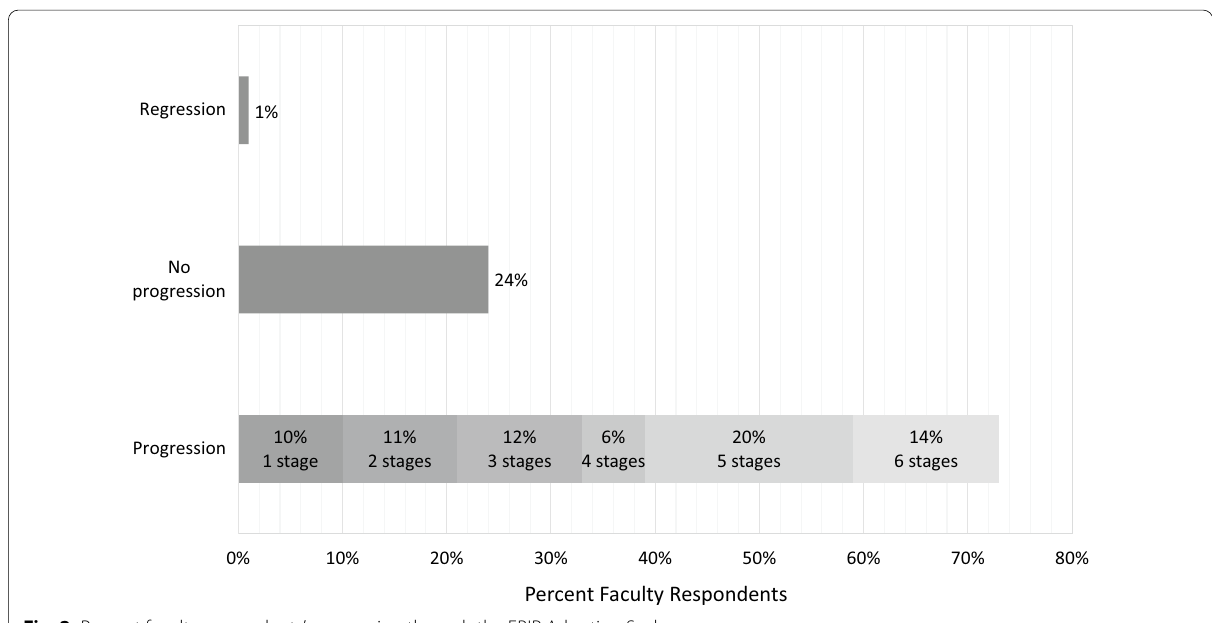
Fig. 2 Percent faculty respondents’ progression through the EBIP Adoption Scale